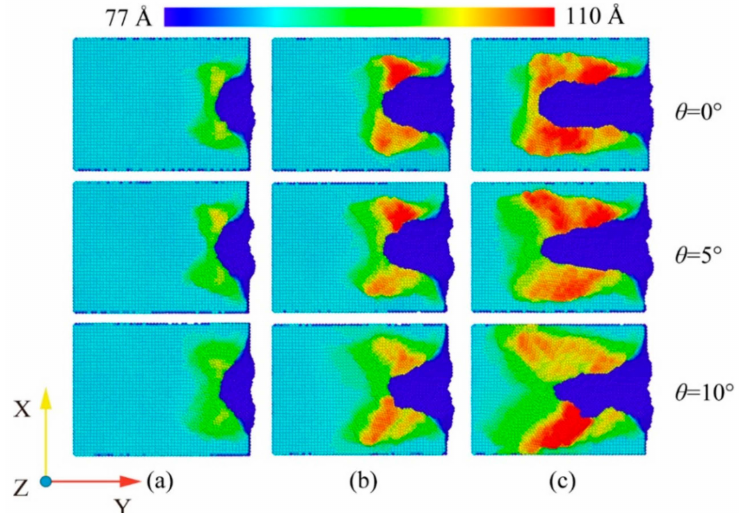
Figure 7. Workpiece surface morphology during wet cutting. ( a ) Cutting distance of 30 Å; ( b ) cutting distance of 60 Å; and ( c ) cutting distance of 100 Å.